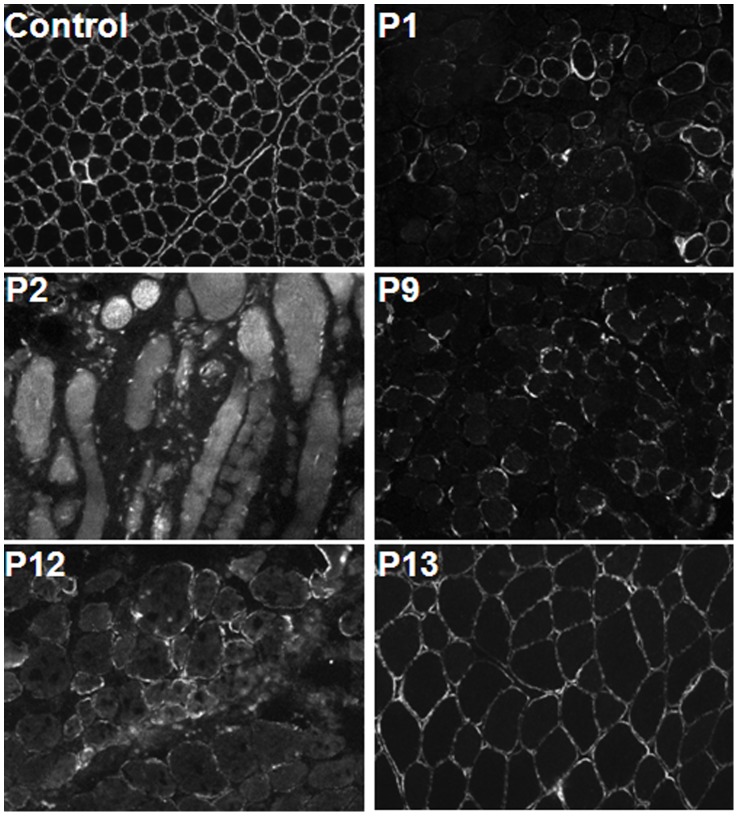
Skeletal muscle immunohistochemistry from patients with dystroglycanopathy mutations.Skeletal muscle cryo-sections from control and dystroglycanopathy patients P1, P2, P9, P12, and P13 immunolabelled with the anti-α-DG IIH6 antibody. P1 and P2 have mutations in FKRP, P9 has a mutation in POMGNT1, P12 and P13 have mutations in POMT1. β-dystroglycan and core α-DG was similar to controls for all patients (data not shown) but the amount of IIH6-reactive glycans varied markedly. In P1 the level of IIH6 reactive glycans was reduced, in P2 absent, in P9 and P12 markedly reduced, and in P13 normal (or near normal) compared to the healthy control.